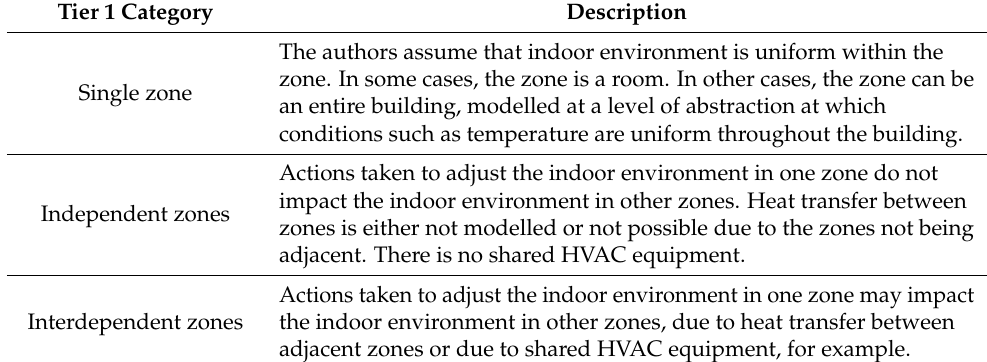
Table 2. Tier 2 categories.